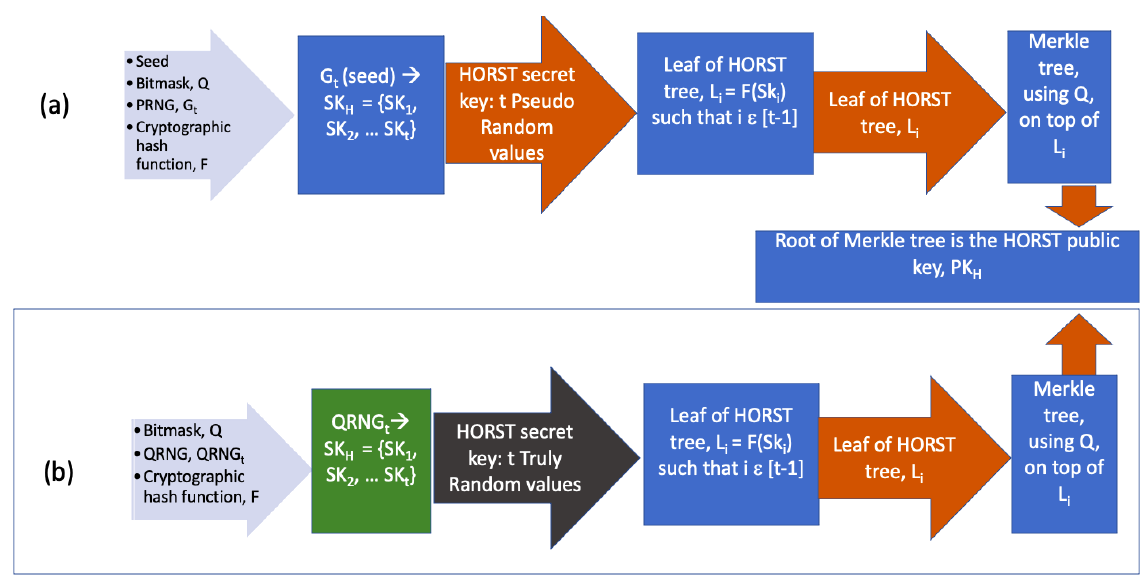
Figure 5. Key Generation: ( a ) Original HORST algorithm and ( b ) Proposed HORST